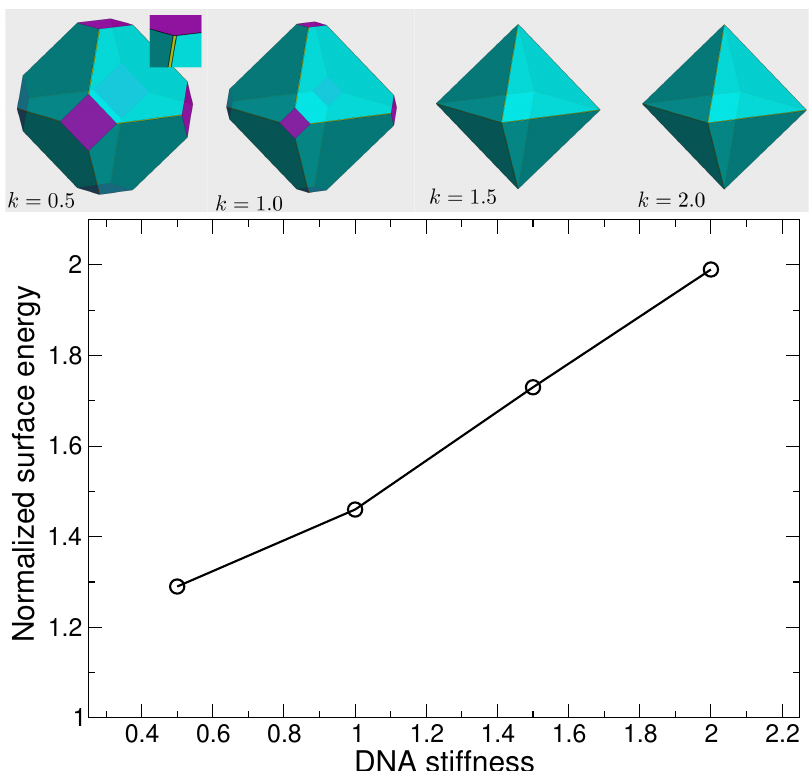
Figure 3. The surface energy of (100) plane as a function of DNA stiffness k a from MD simulations, and their corresponding crystallite shapes. The shapes were generated using WulffMaker [48]. The cyan, purple and yellow plane correspond to (111), (100) and (110) respectively. The (100) plane surface energy increases as the DNA stiffness increases; as a result the contribution of (100) plane in determining the crystal shape decreases. At the stiffness k a = 2.0, the crystallite shape is an octahedron. The contribution of (110) plane (the yellow planes) is not